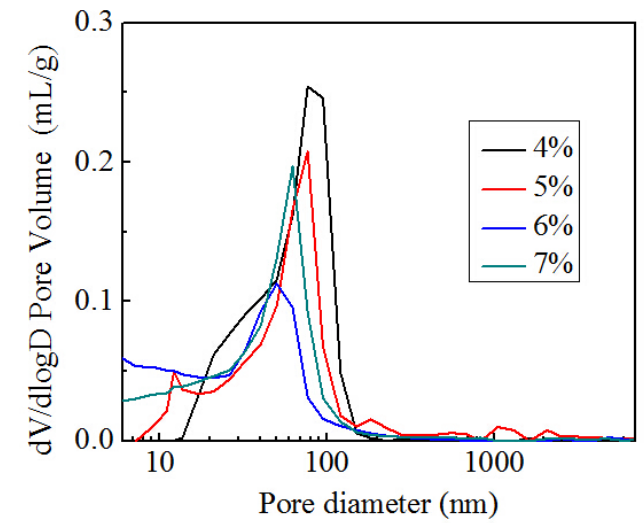
Fig.2. MIP analysis of pore parameters of cement stabilized graded stones with different moisture